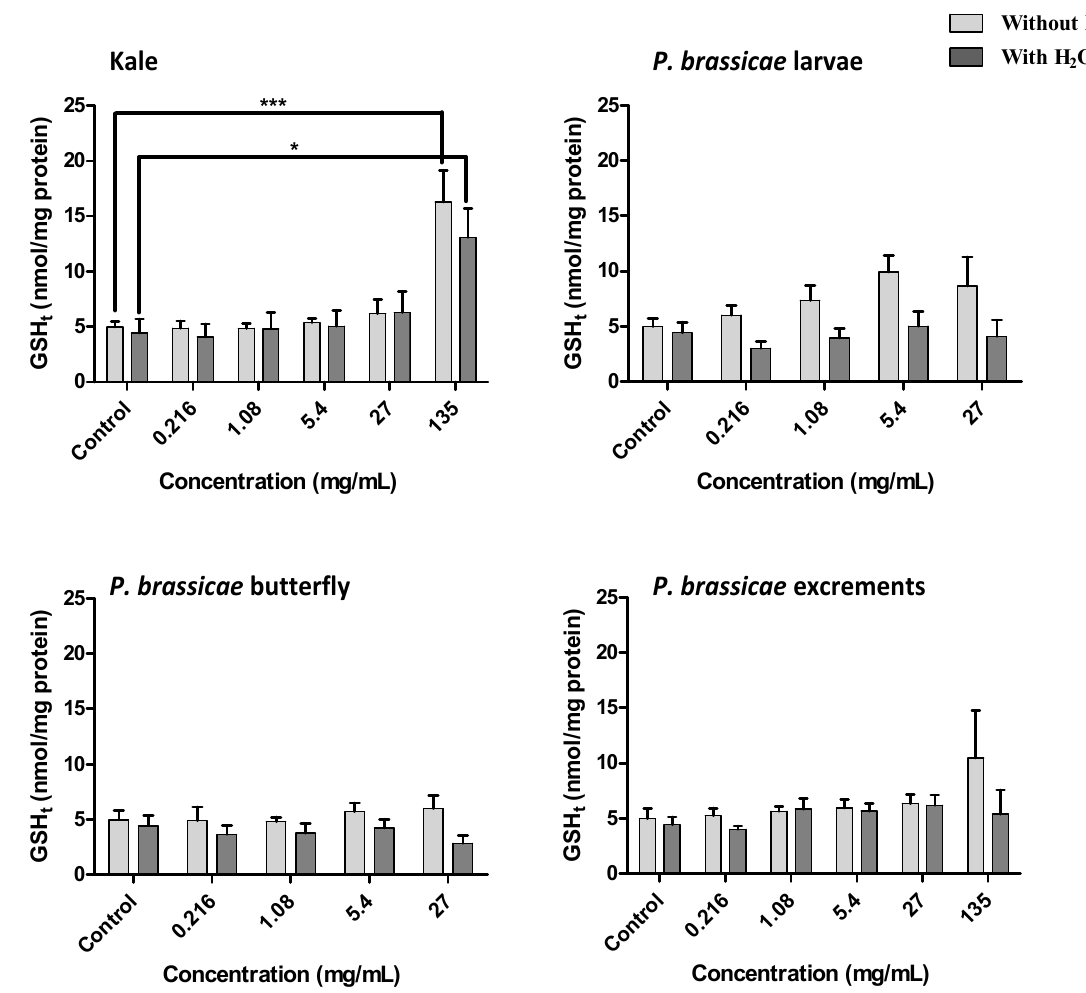
Figure 8. Effect of B. oleracea var. acephala and P. brassicae materials methanolic extracts on total glutathione content of V79 cells, after 24 h treatment, with and without H O -induced oxidative stress. Values show mean ± SE (n = 4). Mean values were 2 2 significantly different compared with the respective control ( * p < 0.05 and *** p <